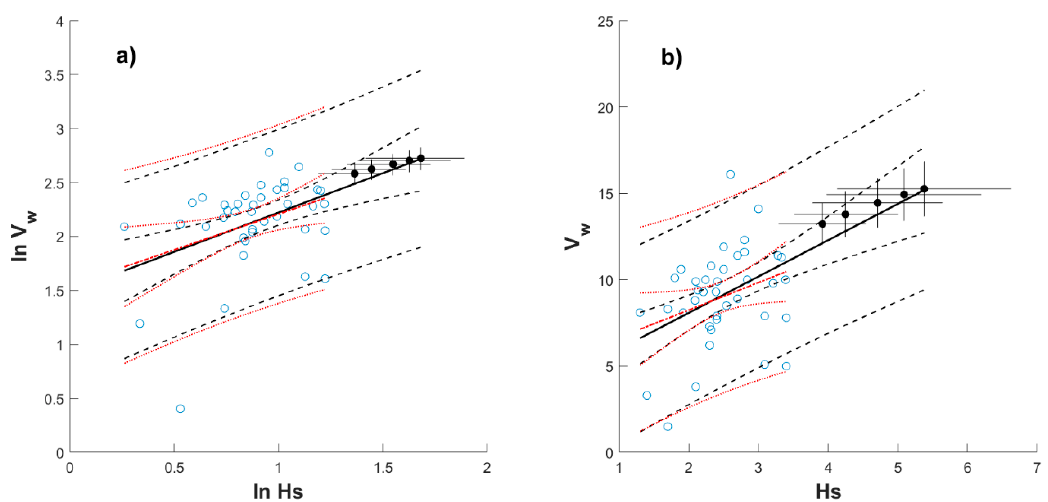
Figure A3. Regression lines and confidence intervals including (solid and dashed lines, respectively) and excluding (dashed–dotted and dotted lines, respectively) T -yr values for April; ( a ) and ( b ) for logarithmic space and linear space, respectively. Filled circles represent T -yr values with embedded perpendicular lines indicating confidence intervals from GEV models.